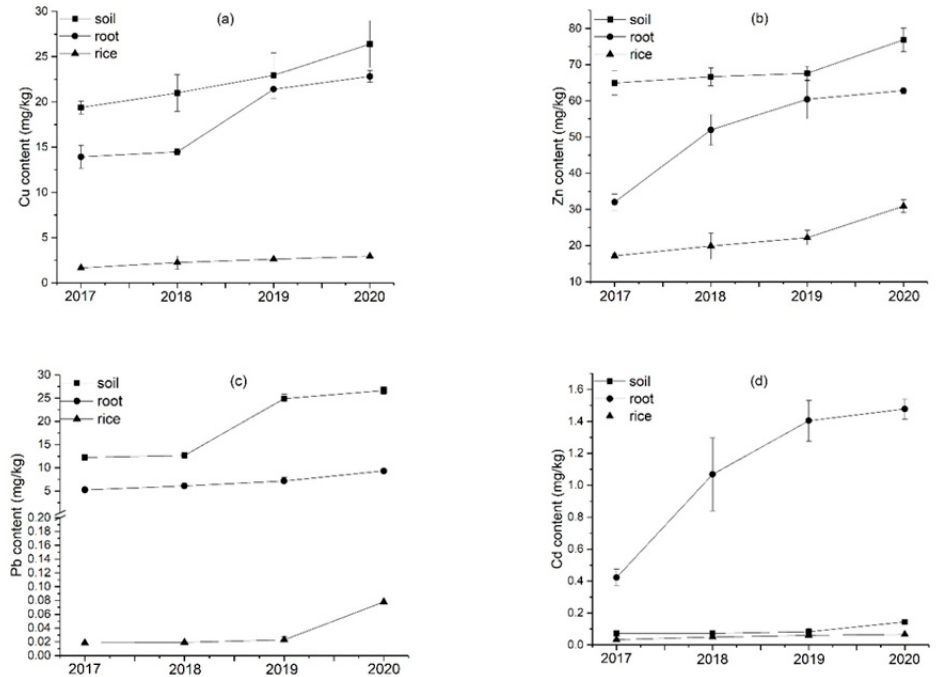
Figure 10. ( a ) Annual increasing rates of Cu content in the soils, rice roots, and brown rice by the application of PM during the four experimental years; ( b ) annual increasing rates of Zn content in the soils, rice roots, and brown rice by the application of PM during the four experimental years; ( c ) annual increasing rates of Pb content in the soils, rice roots and brown rice by the application of PM during the four experimental years; ( d ) annual increasing rates of Cd content in the soils, rice roots, and brown rice by the application of PM during the four experimental years. Data are expressed as means ± SD; n = 3.